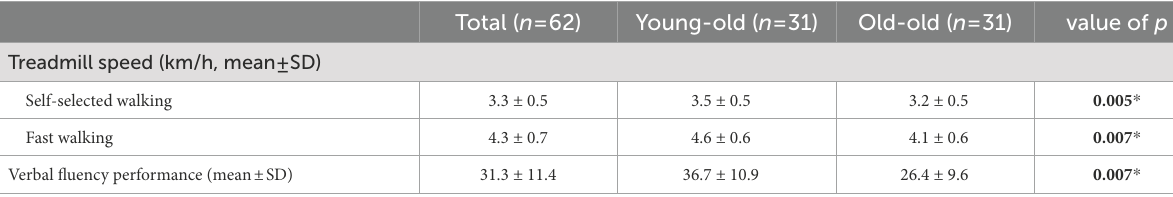
TABLE 2 Treadmill speed and verbal fluency performance during dual-task walking in the young-old and old-old groups.